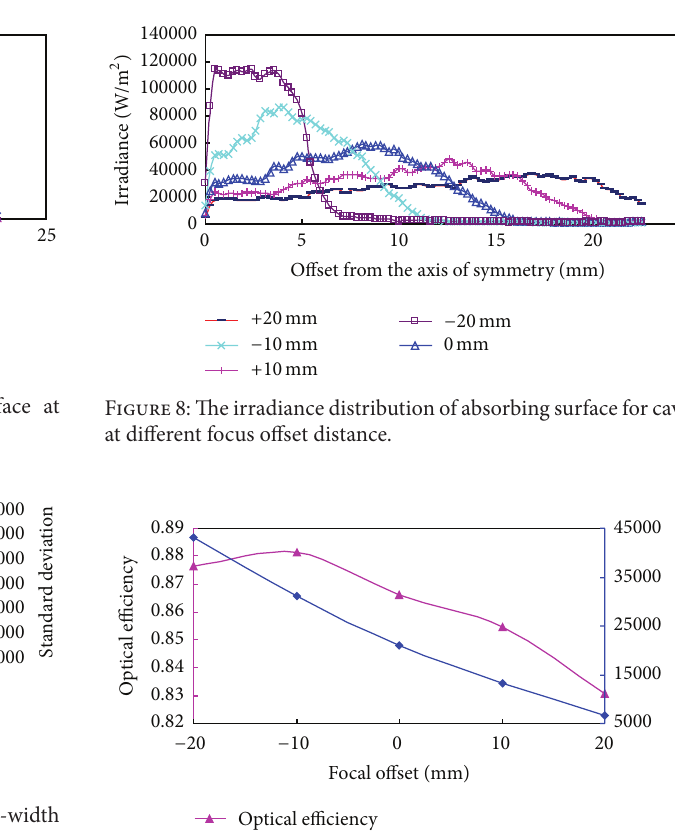
from the symmetry axis. Moreover, the maximum irradiance axis and with the increment of the offset distance from